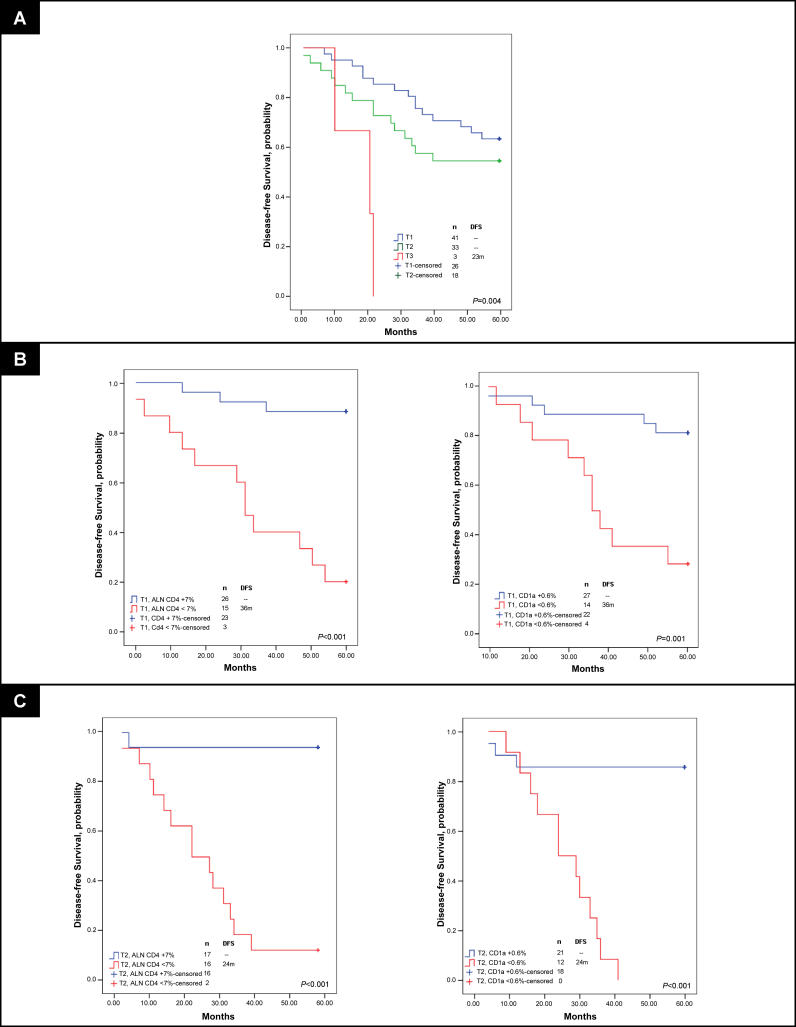
DFS Analysis of Women with Breast Cancer According to Tumor Stage, T1 and T2, and Immune Profile Characteristics, Learning and Test SetsKM curves are shown for (A) median DFS applied to the learning set (n = 29) and test set (n = 48) according to tumor stage; (B) DFS stratified by size of ALN CD4 T cell and ALN CD1a dendritic cell populations among individuals with T1 tumors; and (C) DFS stratified by size of ALN CD4 T cell and ALN CD1a dendritic cell populations among individuals with T2 tumors. Thresholds for ALN CD4 T cell and ALN CD1a dendritic cell populations were determined by receiver-operating-characteristic curves as applied to the learning set (ALN series 1). Median duration of DFS are indicated; – indicates a median DFS greater than follow-up period, 5 y. Of 77 individuals, 33 had disease recurrence. Of 41 from individuals with T1 tumors, 15 had recurrent disease. Of 33 individuals with T2 tumors, 15 had disease recurrence. For ALN selection from the learning set, a single ALN was randomly selected from series 1 or series 2 per individual. Adjusted p-values were determined by the permuted log-rank statistic for comparison of DFS between groups.